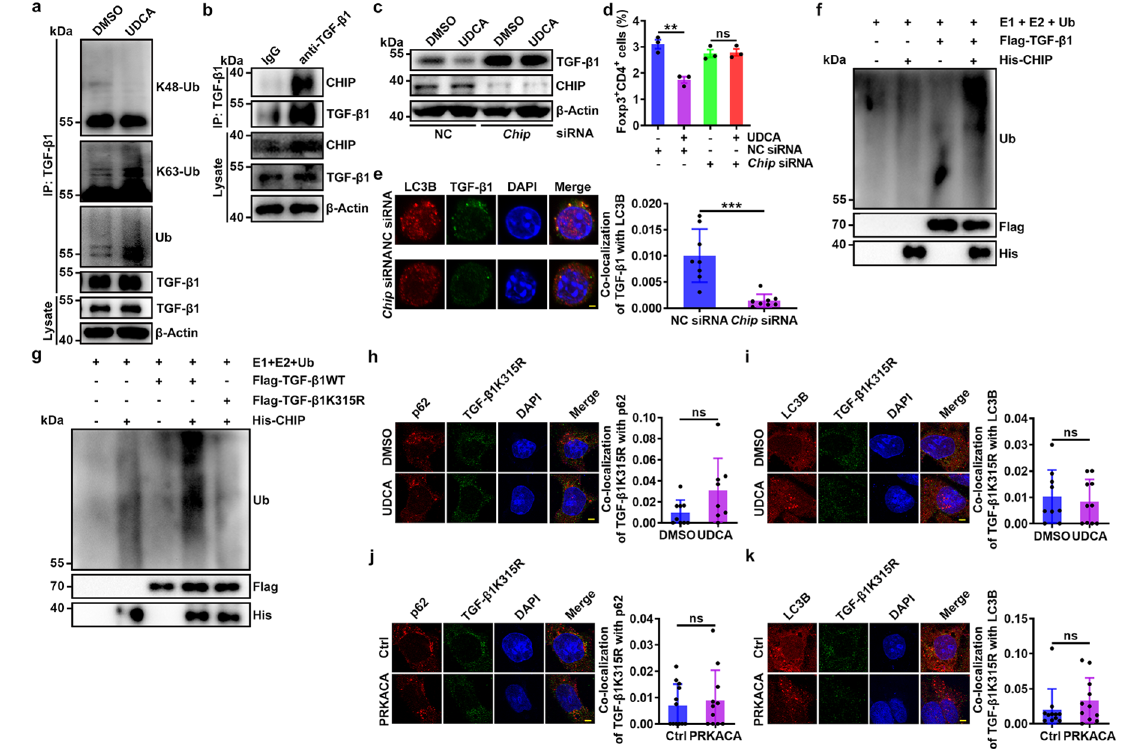
Fig. 4 UDCA promotes TGF- β 1 ubiquitination at K315 by CHIP. a IB analysis of K48-linked, K63-linked and total ubiquitination of TGF- β 1 in naïve CD4 + T cells stimulated with anti-CD3, anti-CD28, 50 μ M UDCA and 1 nM Baf-A1 for 24 h. IB analysis was conducted after IP with anti-TGF- β 1. b IB analysis of CHIP and TGF- β 1 in naïve CD4 + T cells stimulated with anti-CD3 and anti-CD28 for 24 h. IB analysis was conducted after IP with anti-TGF- β 1 or IgG. c – e IB analysis of TGF- β 1 ( c ), FC analysis of Foxp3 + CD4 + cells ( d ) and immuno fl uorescence analysis of LC3B and TGF- β 1. Scale bar, 2 μ m ( e ) in CHIP-knockdown naïve CD4 + T cells stimulated with anti-CD3, anti-CD28 and 50 μ M UDCA for 24 h ( c , e ) or for 4 days ( d ). f , g IB analysis of TGF- β 1 ubiquitination in the presence of E1, E2, Ub, puri fi ed CHIP, and TGF- β 1 ( f ) or TGF- β 1K315R ( g ). h – k Immuno fl uorescence analysis of p62 and TGF- β 1K315R ( h , j ) or LC3B and TGF- β 1K315R ( i , k ) in NIH-3T3 cells treated with 50 μ M UDCA ( h , i ) or transfected with vectors expressing PRKACA ( j , k ) and transfected with the TGF- β 1K315R mutant plasmid for 24 h. Scale bar, 2 μ m. Representative results from two ( e , h – k ) or three ( a – d , f , g ) independent experiments are shown [ n = 3 in ( d ); n = 8 in ( e ); n = 9 (DMSO) or 8 (UDCA) in ( h ); n = 9 (DMSO) or 10 (UDCA) in ( i ); n = 12 (Ctrl) or 8 (PRKACA) in ( j ); n = 11 in ( k )]. ** P < 0.01; *** P < 0.001; ns, not signi fi cant (unpaired two-tailed Student ’ s t test; mean and s.d.). See Source Data fi le for the exact P